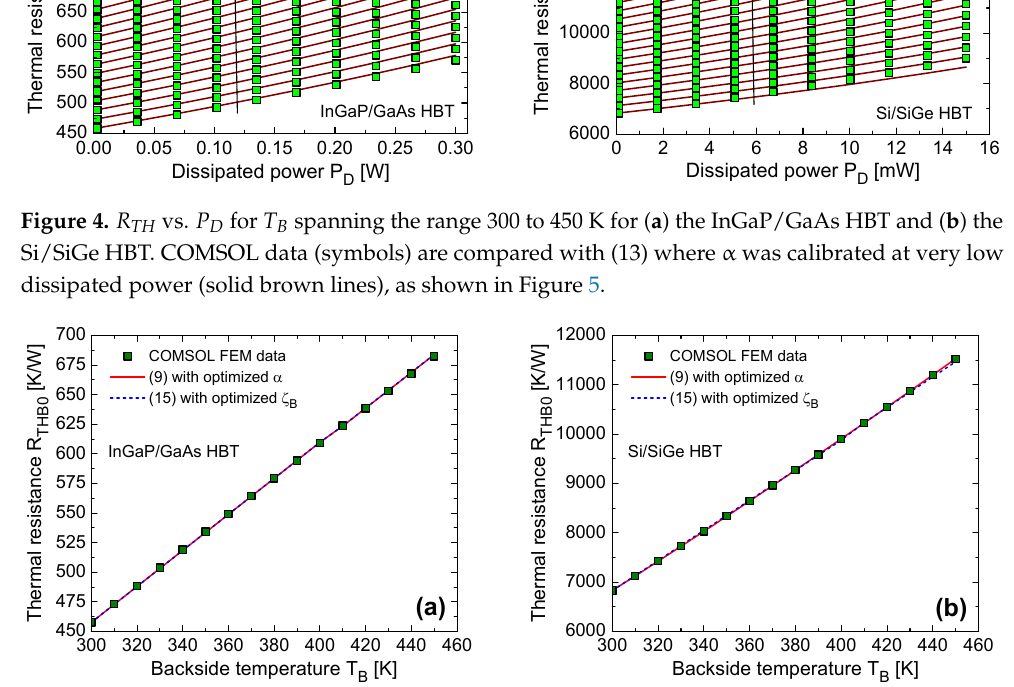
Figure 4. R TH vs. P D for T B spanning the range 300 to 450 K for ( a ) the InGaP/GaAs HBT and ( b ) the Si/SiGe HBT. COMSOL data (symbols) are compared with (13) where α was calibrated at very low dissipated power (solid brown lines), as shown in Figure 5.